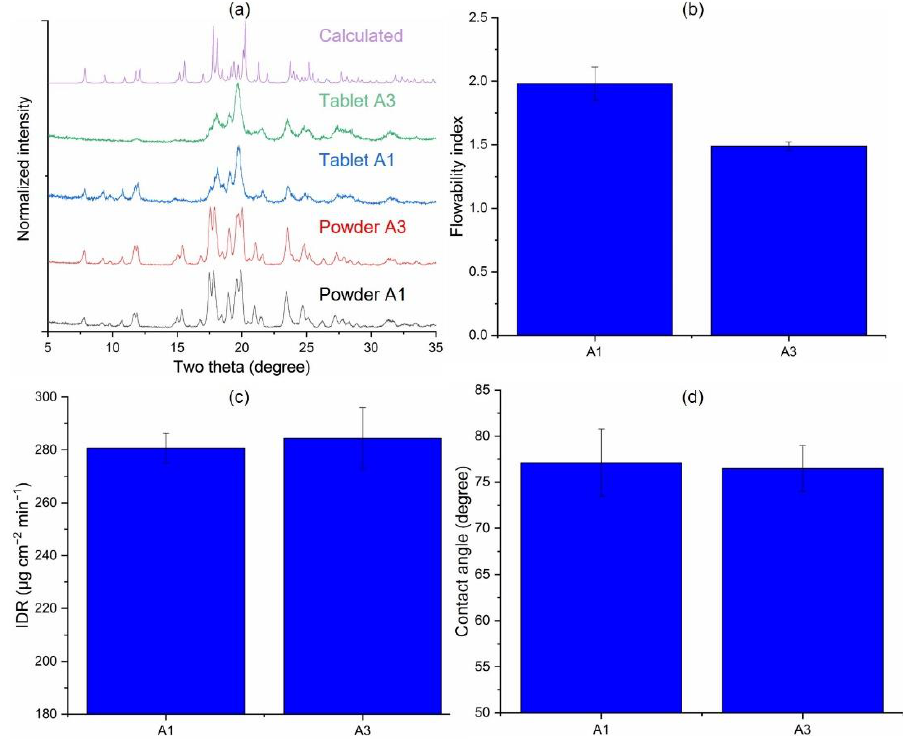
Figure 5. Solid-state characterization, bulk properties of Samples A1 and A3. ( a ) X-ray diffraction; ( b ) flowability ( c ) intrinsic dissolution rate; ( d ) contact angle.